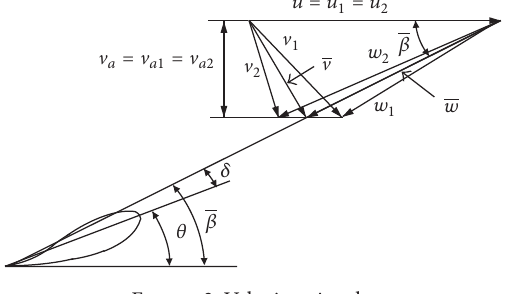
Figure 2: Velocity